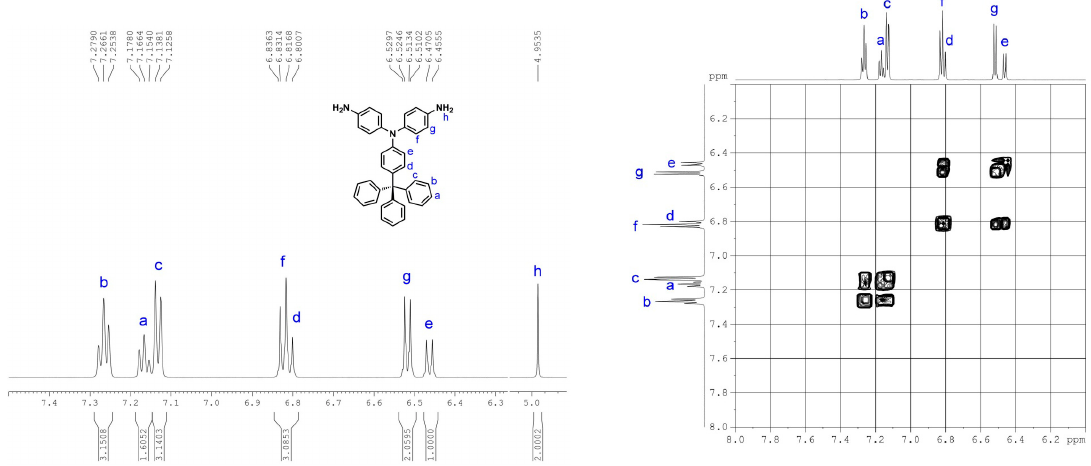
Figure 6. 1 H NMR spectra of 4,4 ′ -diamino-4 ′′ -trityltriphenylamine ( 3 ), measured in dimethyl sulfoxide (DMSO)- d 6 .